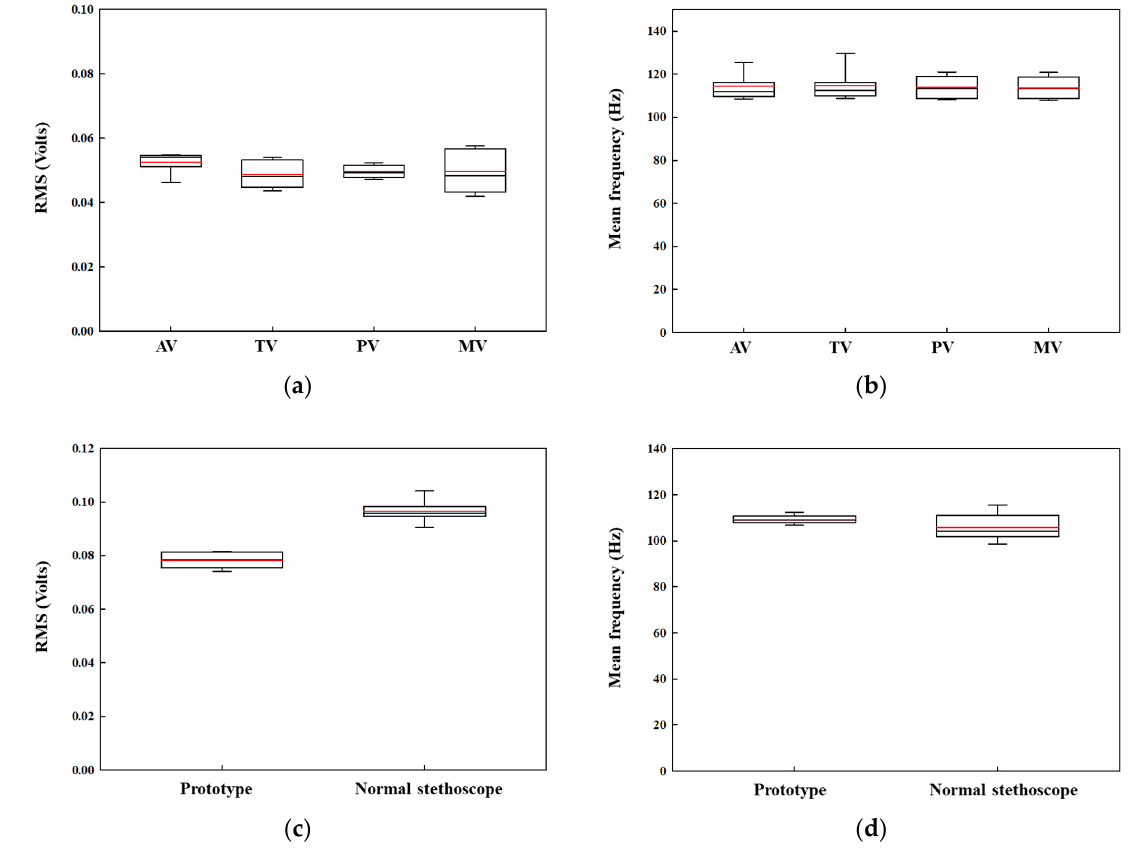
Figure 8. Values of RMS and MEF for EMG data were measured in two tasks: ( a ) RMS value for flexor digitorum profundus muscle in the first task; ( b ) MEF value for flexor digitorum profundus muscle in the first task; ( c ) RMS value for superficial muscle in the second task; ( d ) MEF value for superficial muscle in the second task.